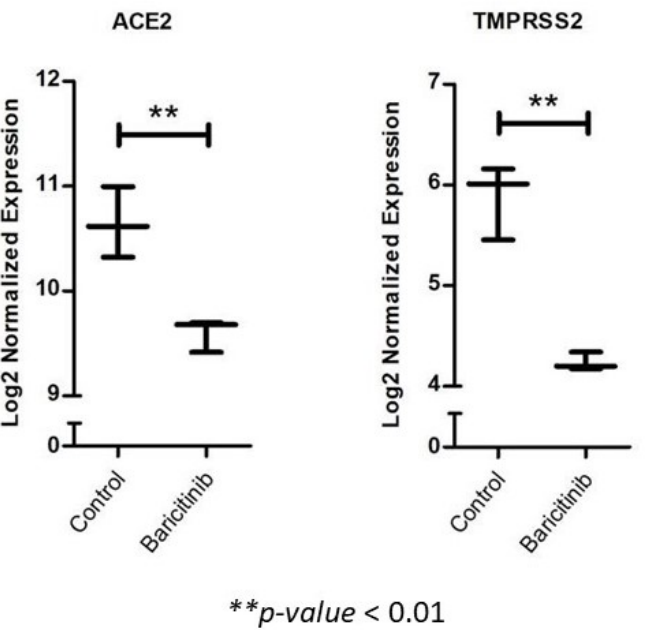
Figure 3. The effect of baracitinib treatment on ACE2 and TMPRSS2 expression (generated from dataset GSE61552). The dataset compiled the expression profile of systemically barictinib-treated and ruxolitinib-treated C3H/HeJ grafted model of alopecia areata. The analysis revealed a significant reduction of ACE2 and TMPRSS2 expression in the baricitinib-treated samples, compared to untreated control ones. ACE2 = angiotensin-converting enzyme 2, TMPRSS2: transmembrane protease serine 2. ** p- value < 0.01.